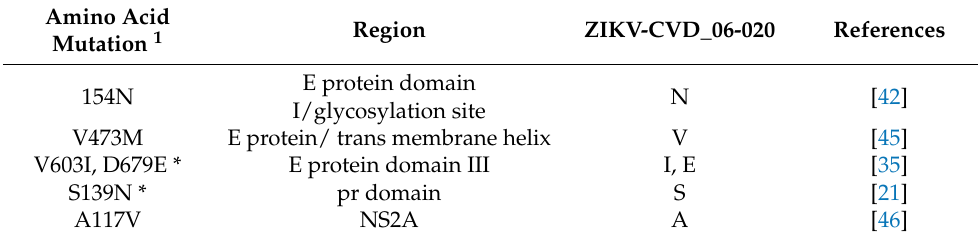
Table 2. Summary of amino acid mutations increasing virulence in infected